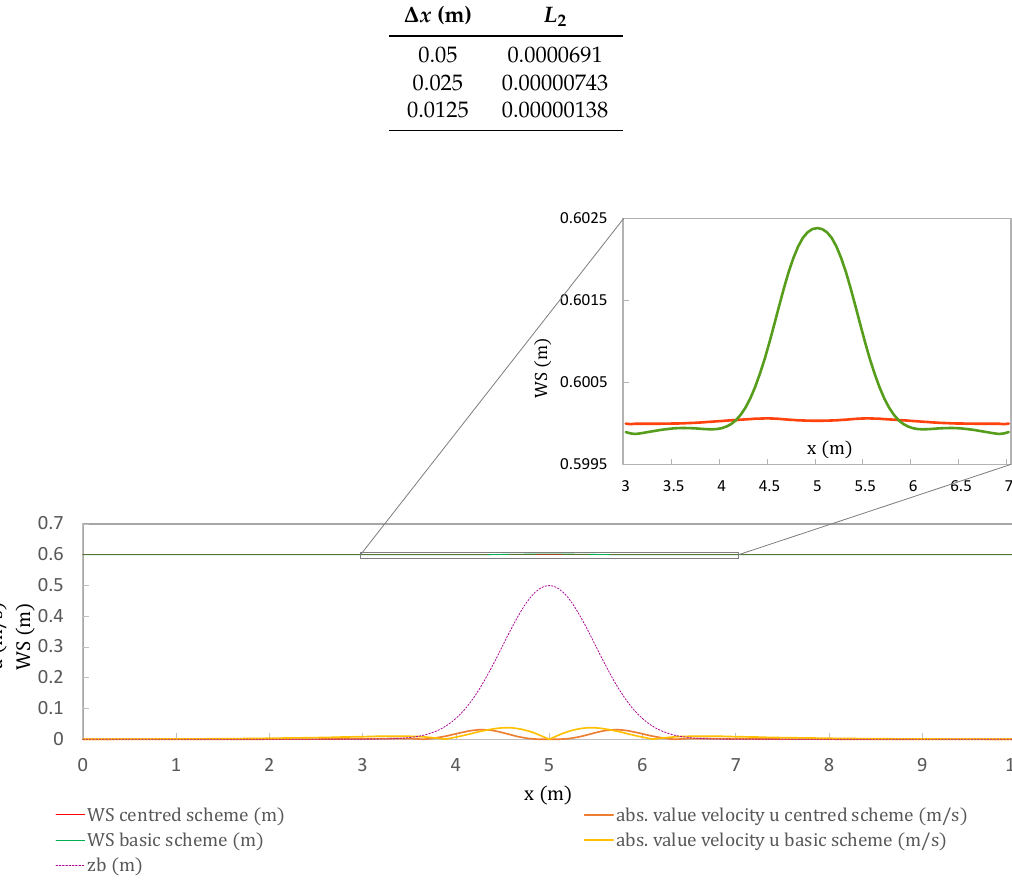
Figure 5. Comparison of basic scheme and centred scheme. z b bottom level (m), WS (m), and spurious velocities